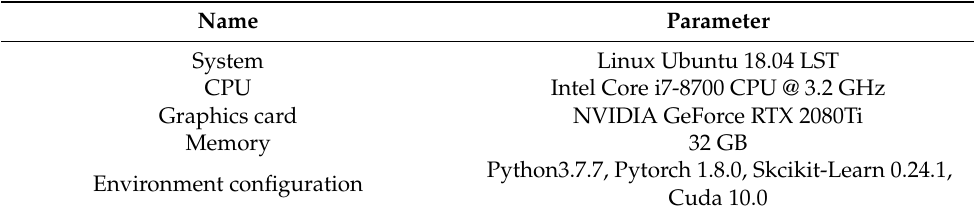
Table 2. Software and hardware environment